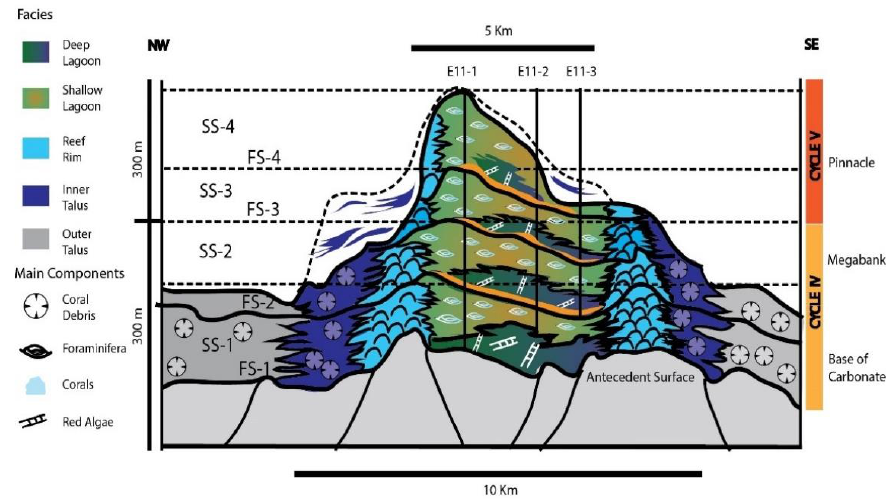
Figure 3. Characteristics and sequence stratigraphic conceptual model of E11 field.